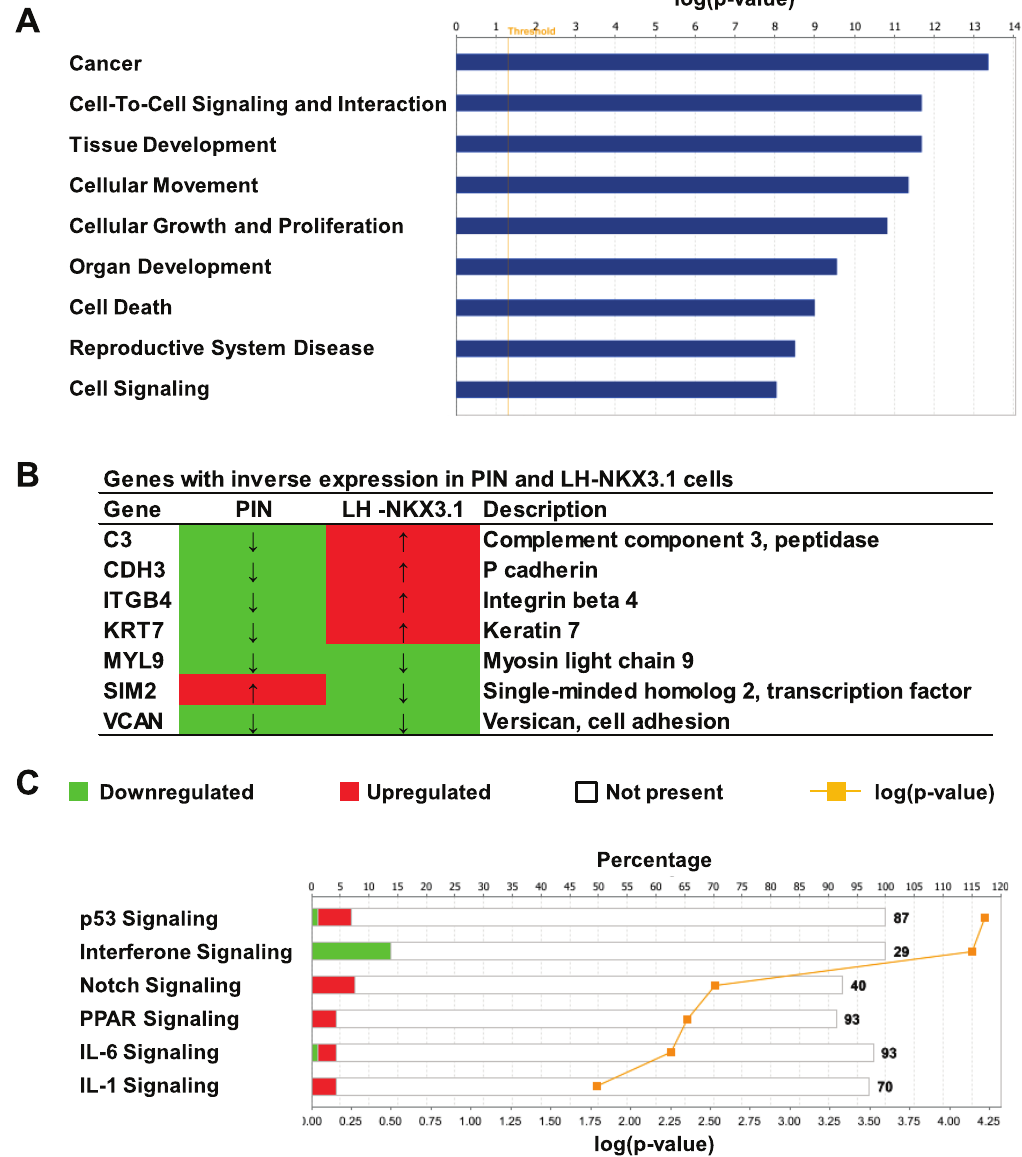
Figure 4. Functions and pathways that are overrepresented in the NKX3.1 gene expression program. ( A ) Select IPA “Functions” significantly overrepresented in the 5× mRNA set. ( B ) List of mRNAs with inverse expression in prostatic intraepithelial neoplasia (PIN; 72 ) and NKX3.1 expressing LH cells. mRNAs shown in red are upregulated whereas those shown in green are downregulated. ( C ) Select IPA “Canonical Pathways” overrepresented in the 5× dataset. The abscissa on the top indicates the percent fraction of all possible pathway components that were represented in the dataset. Since this dataset only contained a relatively small number of 158 mRNAs, a small percent wise overrepresentation of pathway components is statistically highly significant (p < 0.05, see yellow graph). nodes predicted to be activated by TNF α were also upregulated by signaling. Further annotation of the TNF α network also connected NKX3.1 (Supplementary Table 4). Consistent with MAP kinase TNF α to NKX3.1-induced suppression of cell movement through signaling being a major downstream pathway activated by TNF α , downregulation of action-myosin based mobility components and we found that a chemical inhibitor of JNK but not p38 could par- enhancement of cell adhesion through upregulation of laminins tially antagonize NKX3.1-induced expression of HSPA6 and HES1 (Figure 5A). Both processes are considered bona fide hallmarks of (Figure 6B). tumor suppression. Close examination of every TNF α expression edge revealed considerable concordance between the definition of the edge (based on the published literature) and the actual expression p53 network. Another high scoring network featured the tumor of the target node in response to NKX3.1. Fourteen first degree suppressor p53 at the center with first degree edges to 8